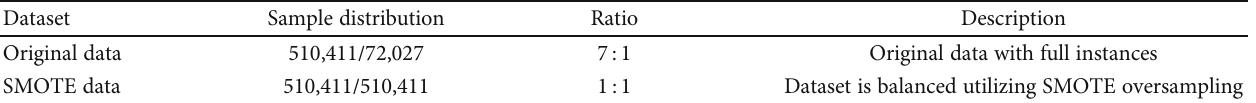
Table 3: Dataset description.